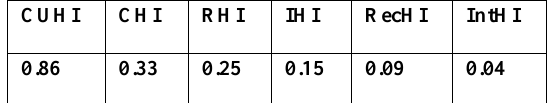
Table 9: Heterogeneity Indexes of various Land Use classes